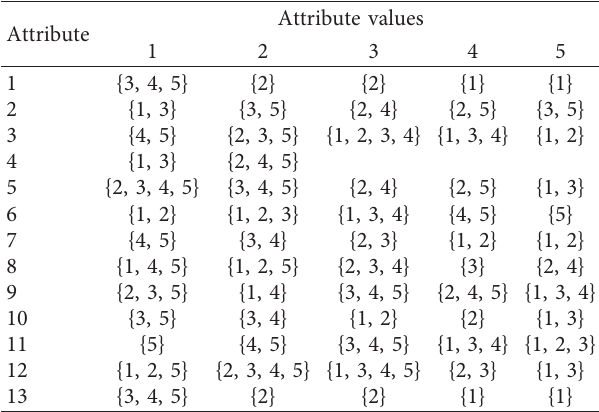
Table 5: Support sets of the attribute values of the Boston housing